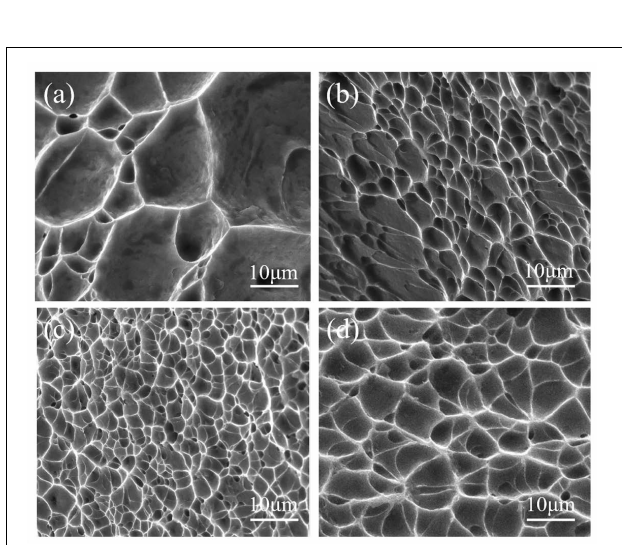
FIGURE 6 | Fractographs of different tensile fracture surfaces: 723 K (a) , 823 K (b) , 923 K (c) , and 1023 K (d)